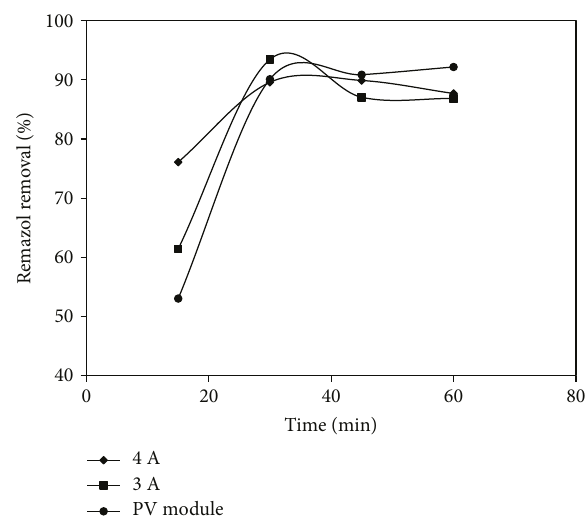
Figure 4: Comparison between current intensity controlled with the power source and one module solar: 4A, 3A, and PV module.